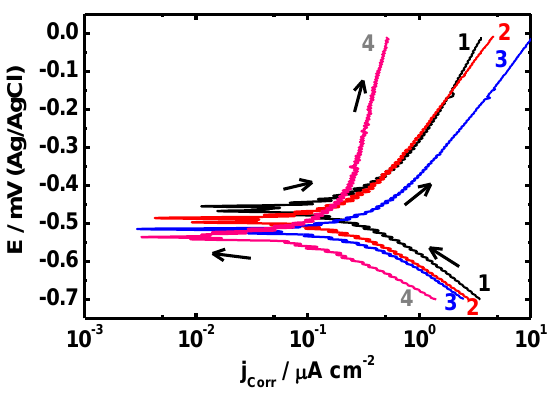
Figure 4. Potentiodynamic polarization curves of γ-TiAl alloy after ( 1 ) 0.0 h; ( 2 ) 1.0 h; ( 3 ) 4.0 h and ( 4 ) 24 h immersion in 3.5% NaCl solution at room